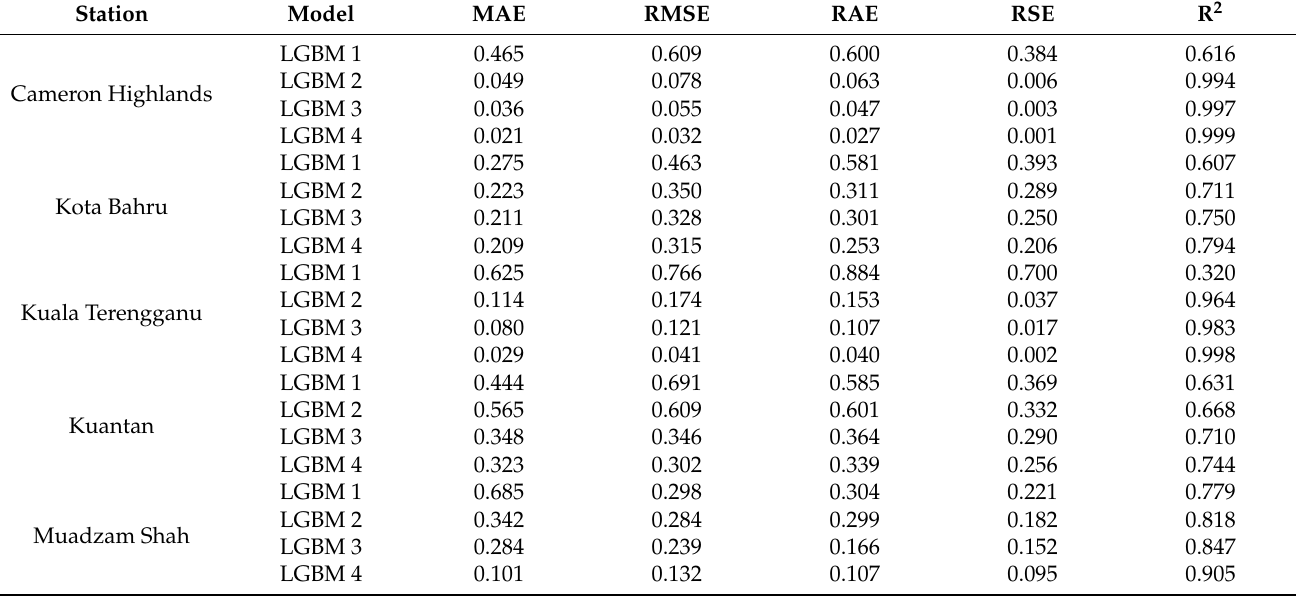
Table 4. Statistical evaluation of LGBM model with different meteorological variables.